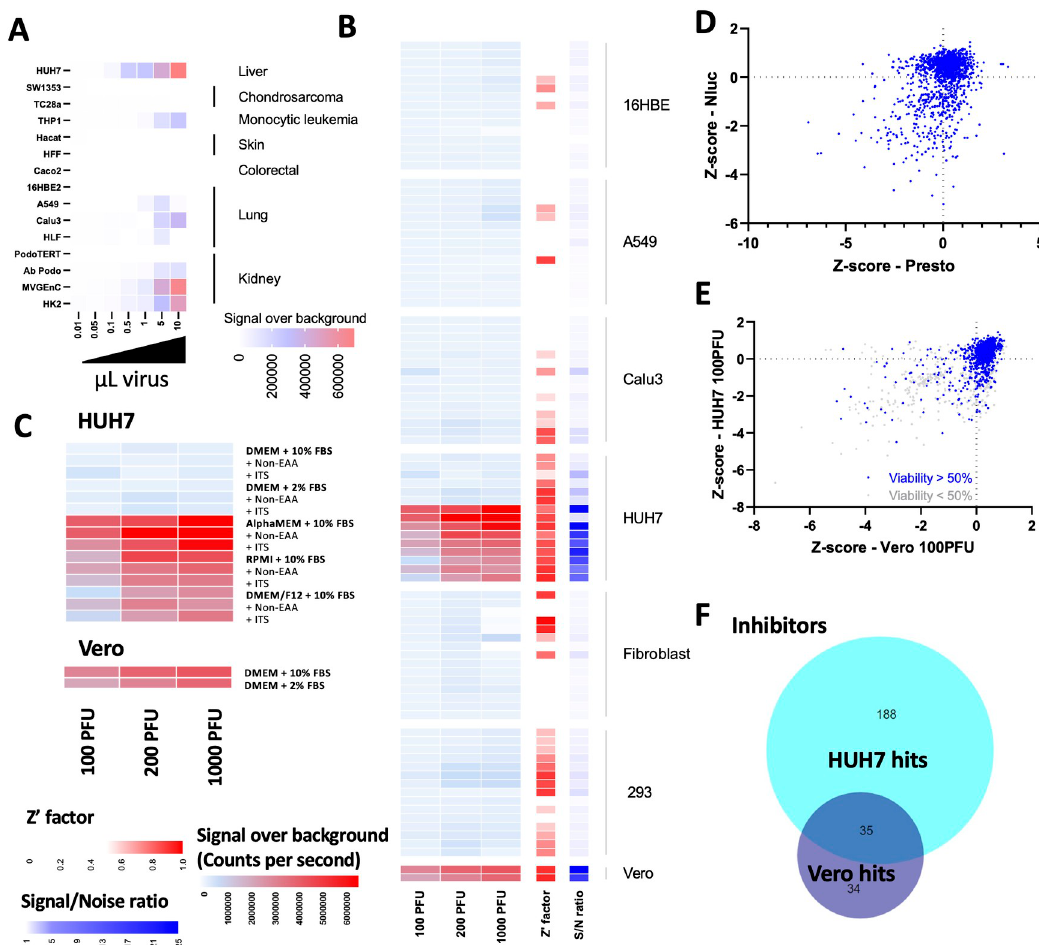
Fig 4. Replication of SARS-CoV-2- Δ Orf7a-NLuc in human cell lines. A) SARS-CoV-2 replication in human cell lines. Five thousand cells per well were seeded and infected as in Fig 3A . All cells were grown in the recommended growth medium, detailed in Table 1 . The NLuc activity after 3 days was used to assess the degree of virus replication. NLuc activity above the baseline activity is shown as a heat map. Each box is the average of 2 biological repeats of each cell line at each virus dose, with the same findings observed when 2000, or 10,000 cells were seeded. B) Lung epithelial, fibroblasts, HUH7 and 293T cell lines were grown in 15 different growth medium compositions. NLuc activity over background three days after infection is shown. Each row represents a different growth medium as indicated in C). Each box represents 4 replicate measures of replication. Similar findings were observed in n = 6 biological repeats. Z’ factors were calculated for each virus dose using ‘virus only’ wells as negative controls, the average Z’ factor for each growth medium is shown. The signal-to-noise ratio of infected cells relative to ‘virus only’ wells are also shown. C) NLuc activity above background three days after infection in HUH7 cells. Each box represents 4 replicate measures of replication. Similar findings were observed in n = 6 biological repeats. D) The effects of 1971 FDA-approved compounds on the replication of SARS-CoV-2- Δ Orf7a-NLuc (100 PFU/well, MOI 0.02) in HUH7 cells grown in alpha-MEM supplemented with 10% FBS. Five thousand cells were treated with 10 μ M of each compound for 24 hrs prior to infection with 100 PFU of virus. Virus replication progressed for 72 hrs as in Fig 3A. E) Comparison of compounds identified by screening for HUH7 and Vero cells Z- scores for luciferase activity are shown. Comparison and overlap of inhibitors identified in the compound screening for HUH7 and Vero cells.